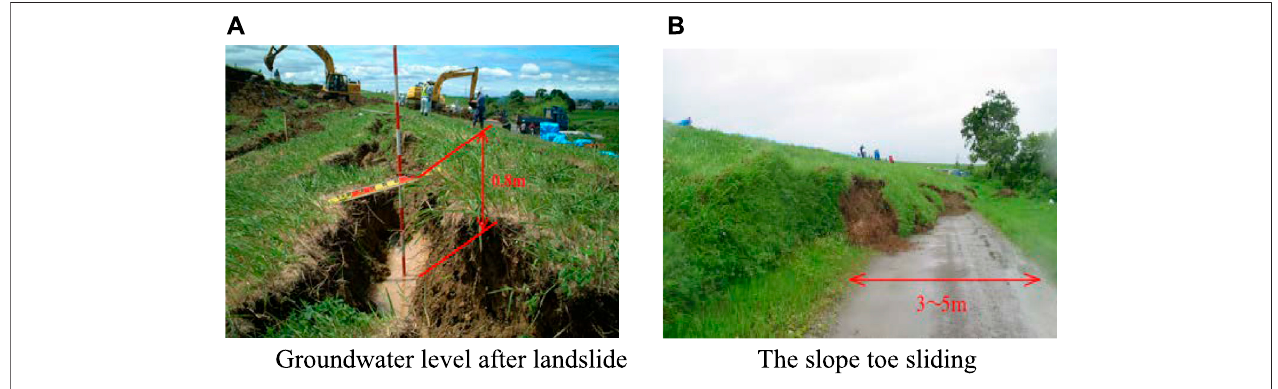
FIGURE 1 | Sliding failure of a river bank slope during the earthquake. (A) Groundwater level after landslide. (B) The slope toe sliding.